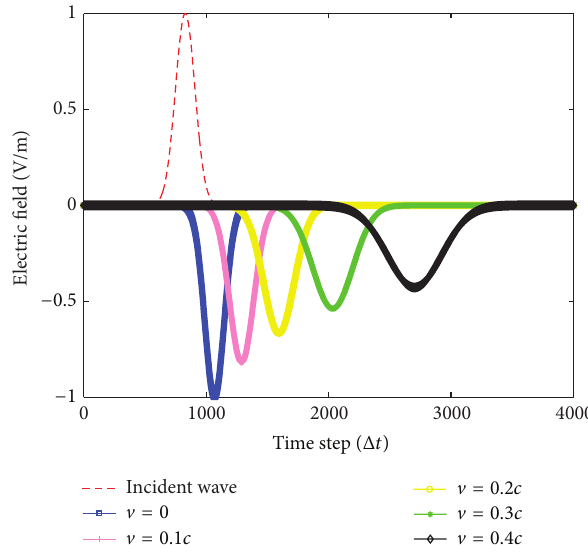
Figure 8: The time-domain scattered waveforms of the moving conducting surface excited by the Gaussian